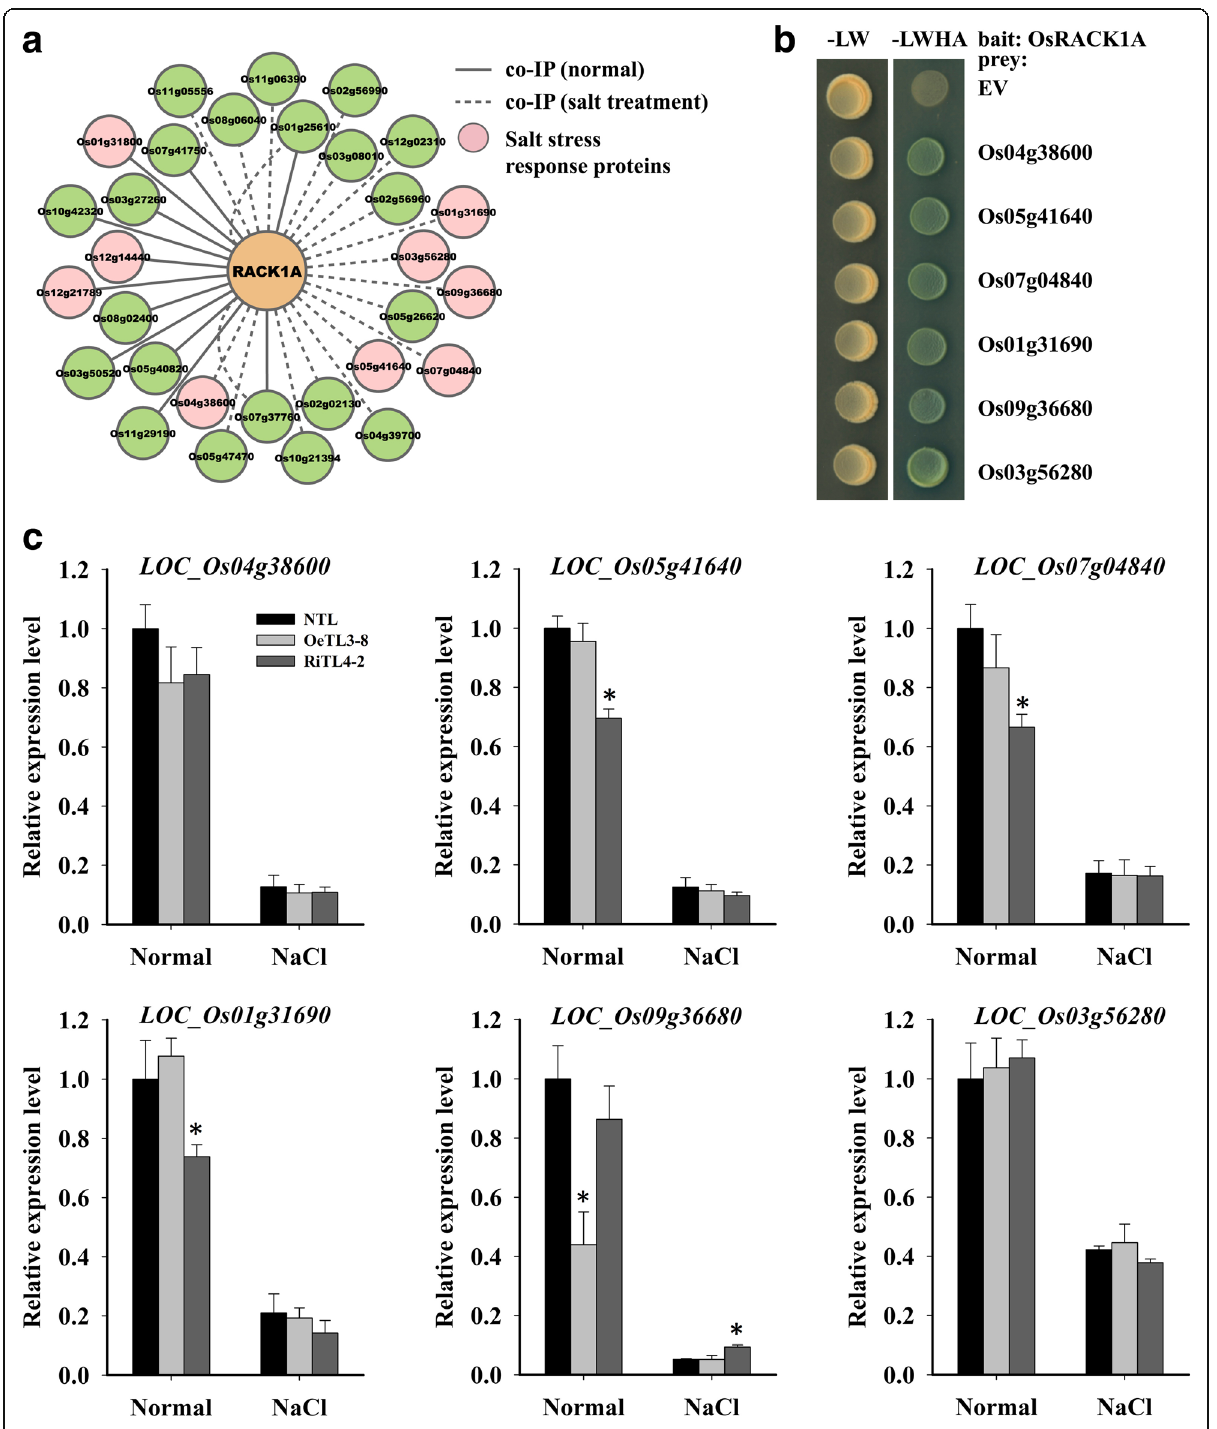
Fig. 7 OsRACK1A directly interacts with stress-response proteins. a OsRACK1A interaction proteins screening using co-IP in both normal and salt stress (150 mM NaCl for 24 h) conditions. b Verifying the protein interactions by yeast two hybrid assay. c Quantitative RT-PCR analysis of the expression of OsRACK1A interactors in response to salt stress (150 mM NaCl for 24 h). Data shown are the means ± SE of four biological replicates. An asterisk indicates a significant difference ( P < 0.05) versus stressed